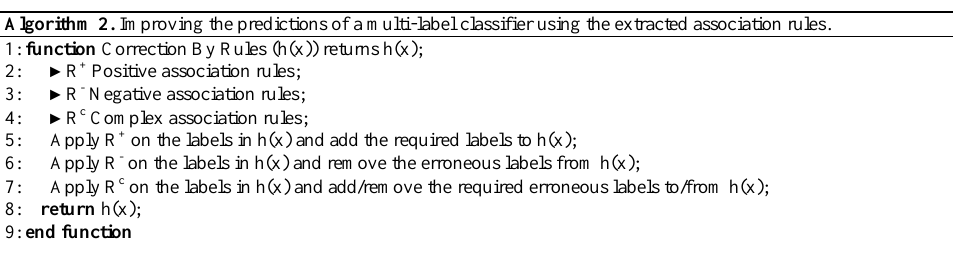
Algorithm 2. Improving the predictions of a multi-label classifier using the extracted association rules. 1: function Correction By Rules (h(x)) returns